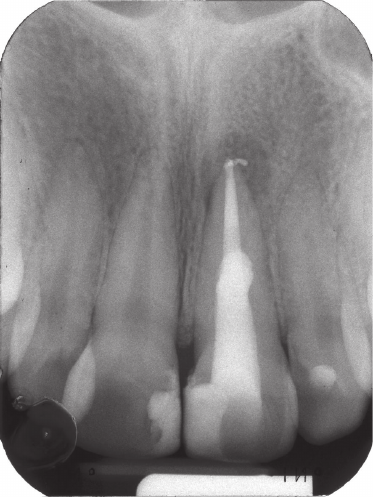
Figure 5: Postoperative